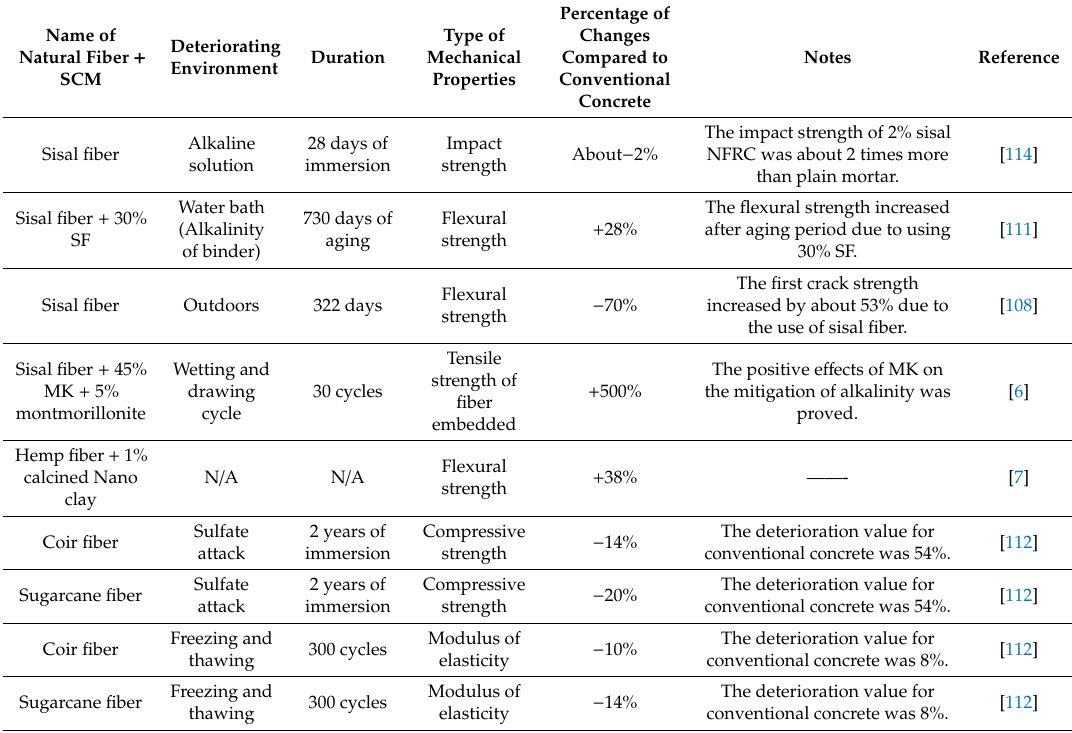
Table 2. The e ff ect of SCMs on the natural fiber performance in cementitious